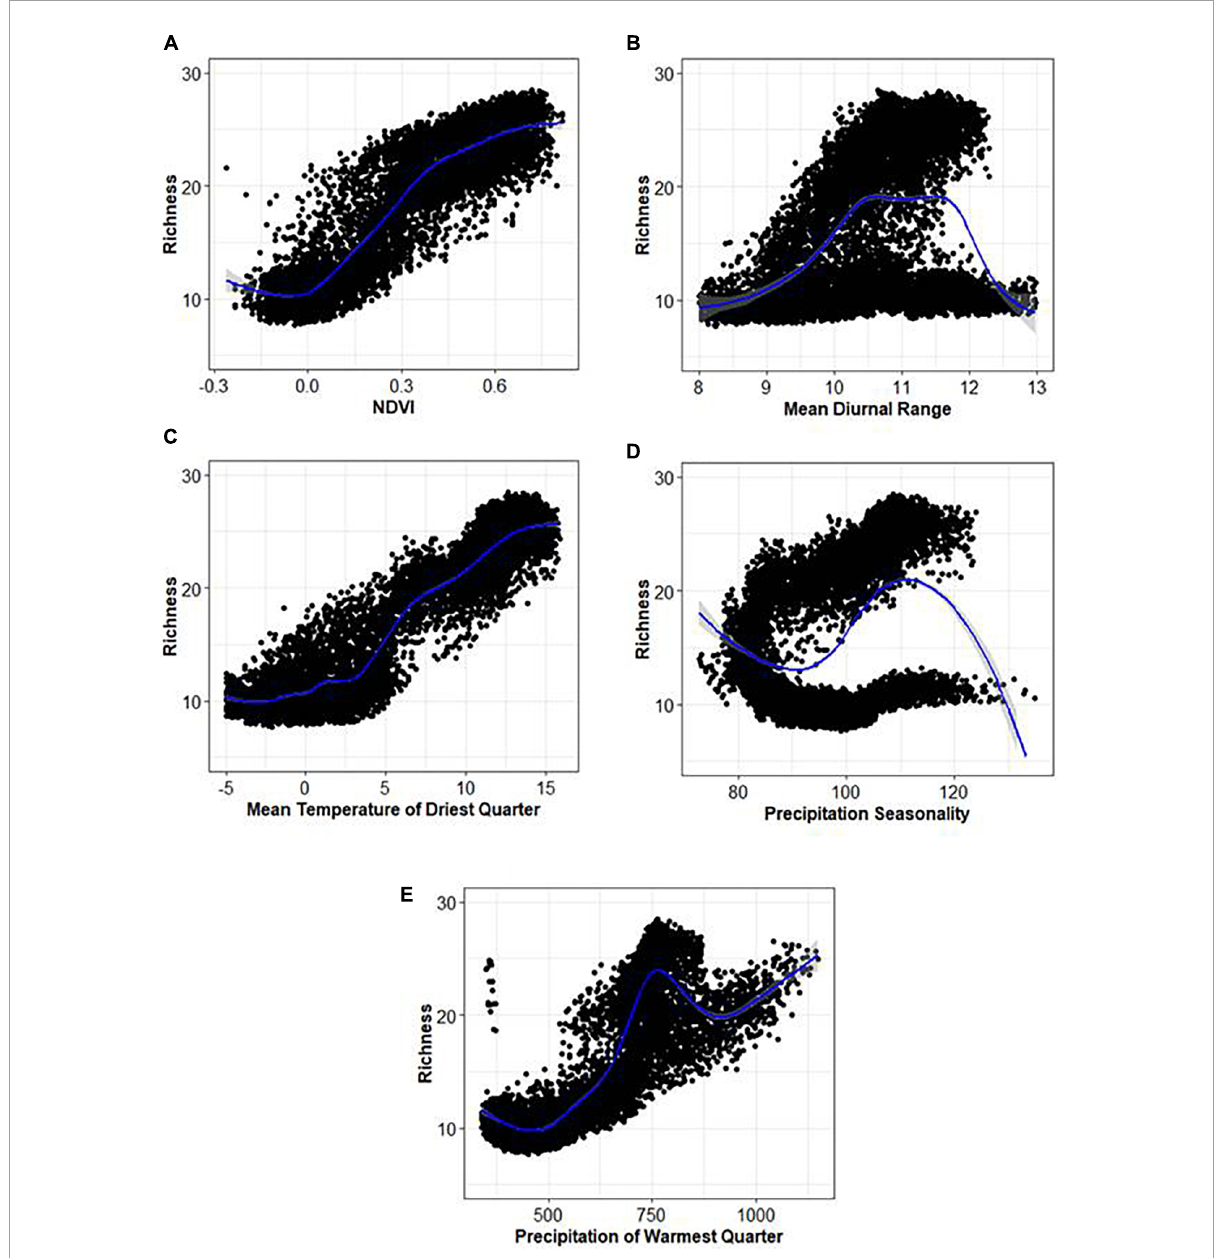
FIGURE6 (A–E) Examples of partial dependency plot showing the relationships between the predicted tree species richness with important predictor variables.